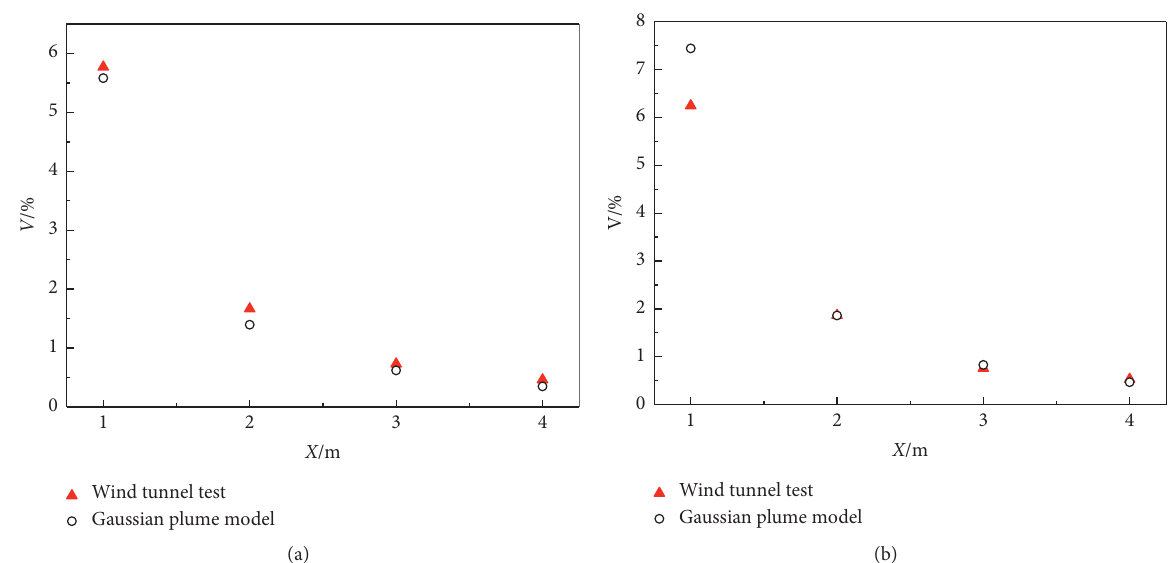
Figure 2: Volume-concentration distribution of different downwind distances from a height of 0.45m (a) Test 1. (b) Test 2.